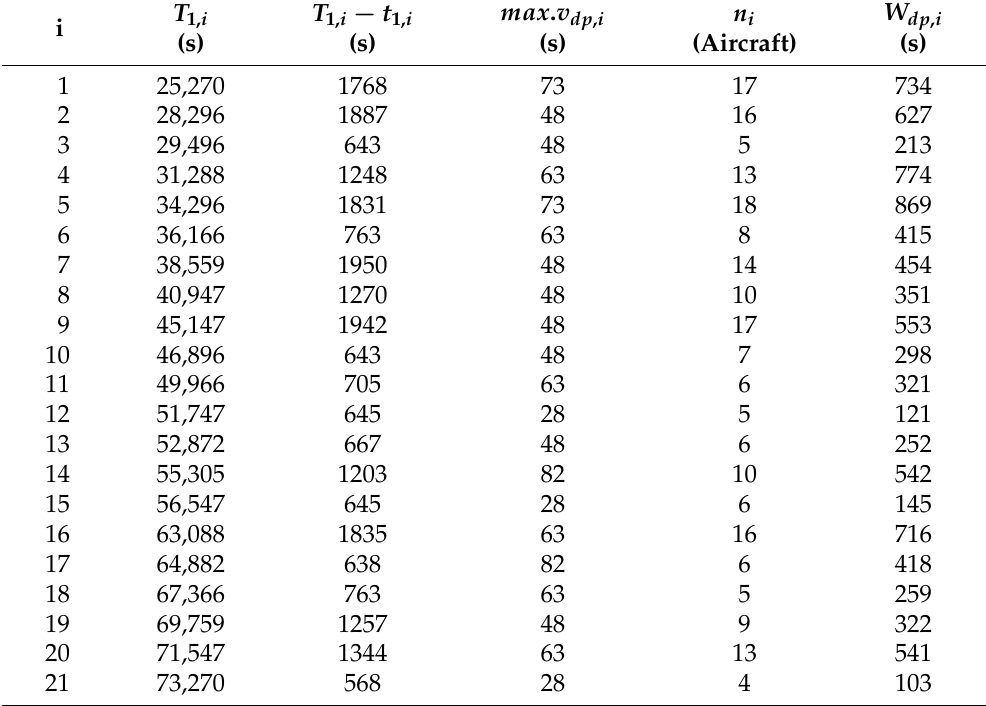
Table 3. OL time intervals and departure waiting times in one